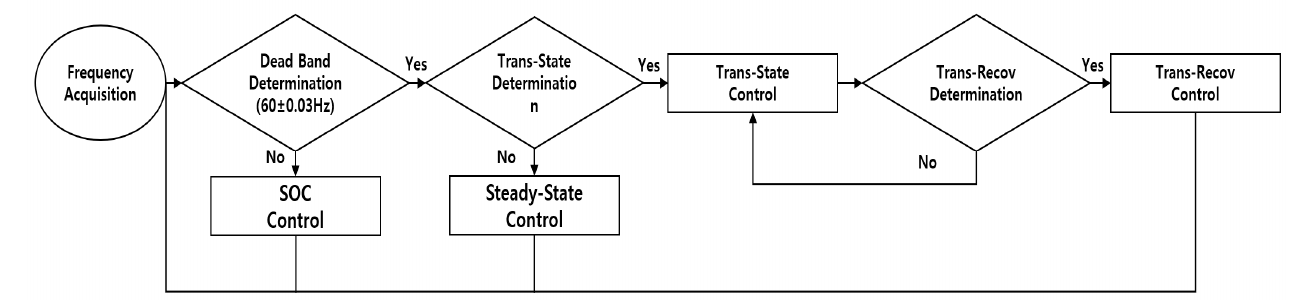
Figure 6. ESS modeling structure.